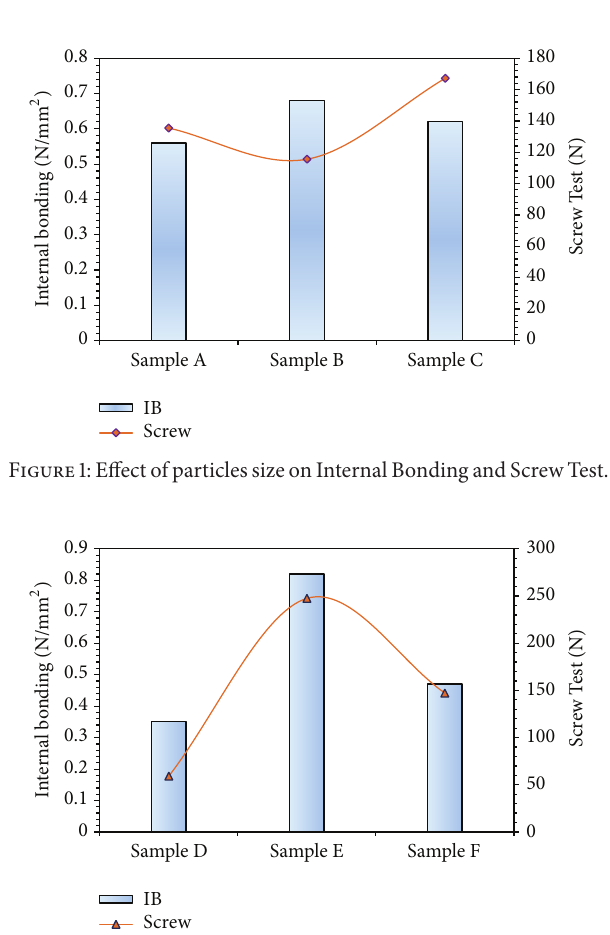
Figure 2: Effect of weight fraction on Internal Bonding and Screw Test.